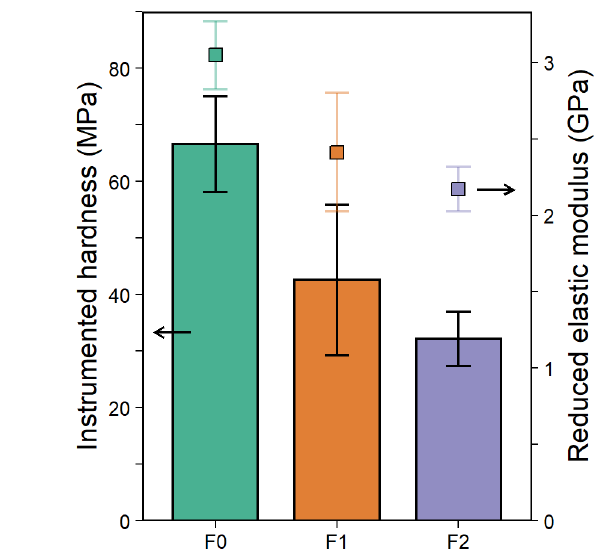
Figure 5. Pendulum hardness and indentation results of the coating films.